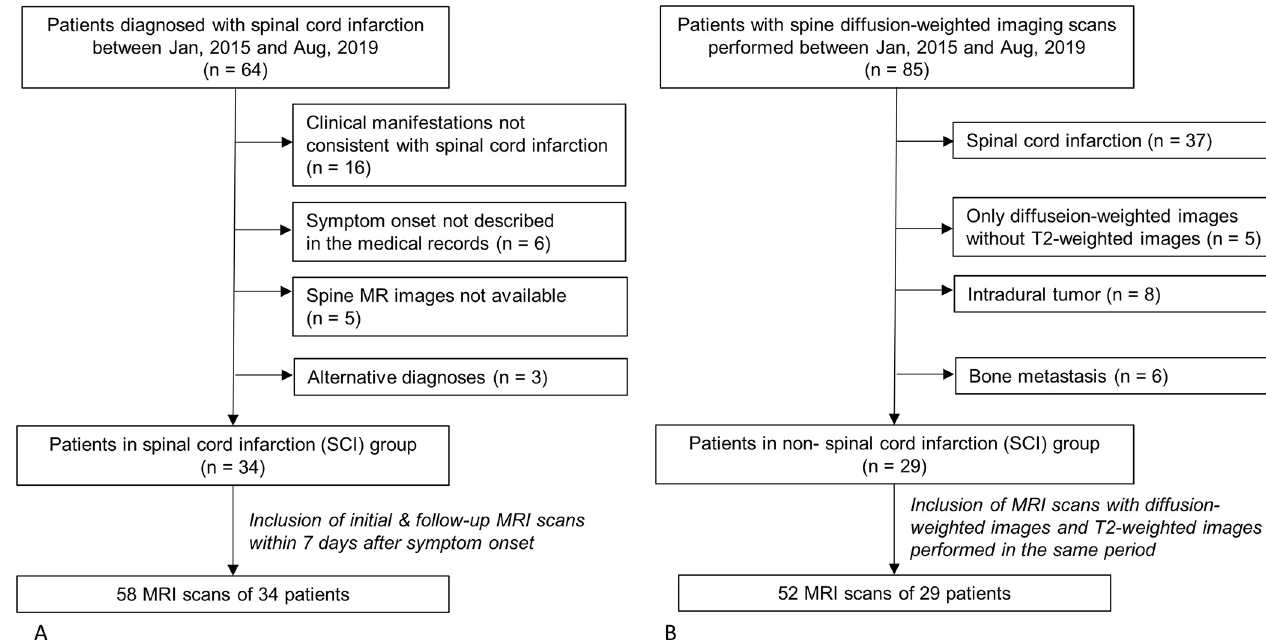
Fig 1. Flowchart of the study population recruitment. A, Spinal cord infarction (SCI) group. B, Non-spinal cord infarction (SCI) group.